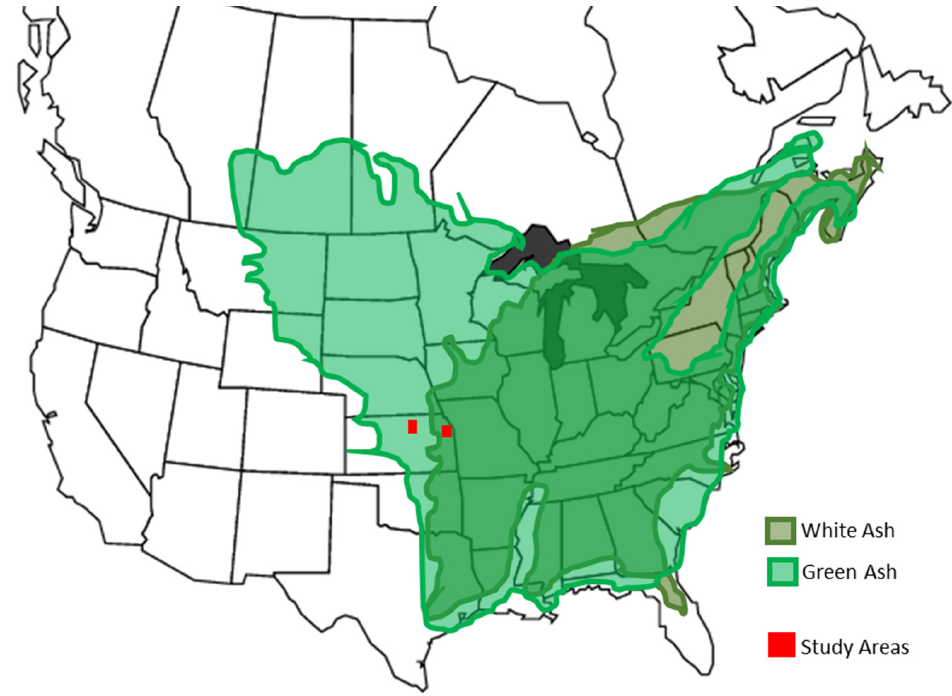
Figure 1. Map showing geographic ranges for natural growth of Fraxinus americana (white ash) and Fraxinus pennsylvanica (green ash) in North America. Red rectangles show the locations of the two general sampling sites described in this paper. Note that the sites are peripheral to the species’ spatial range. Data source: United States Geological Survey (USGS).